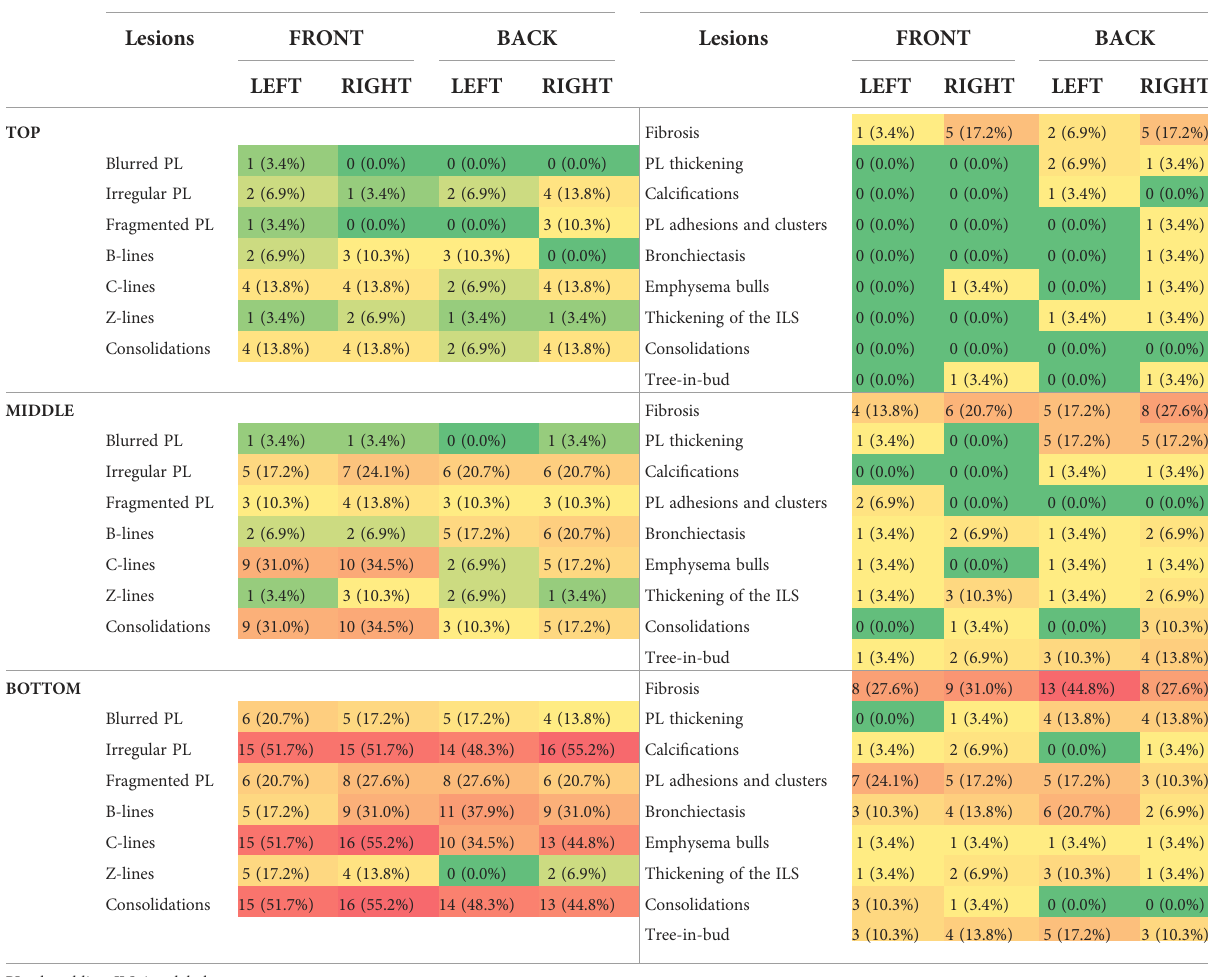
TABLE 1 Distribution of each lesion detected in lung ultrasound (LUS) and high-resolution computed tomography (HRCT) by lung region. LUNG